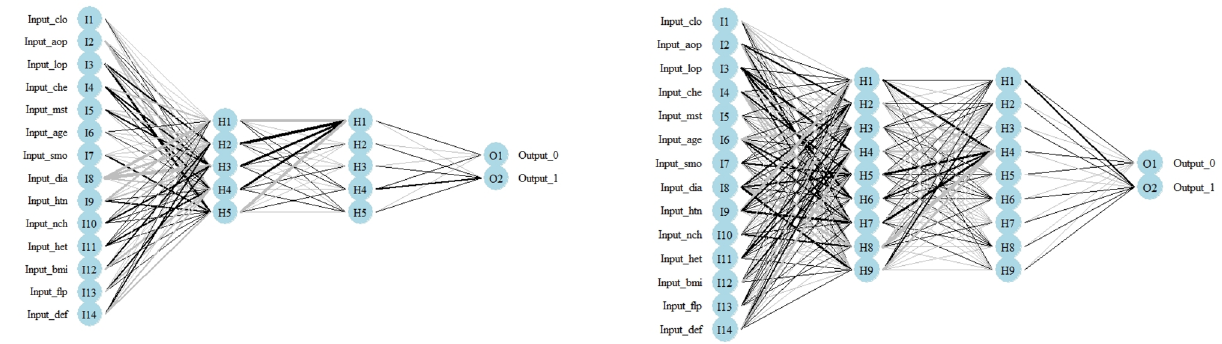
Figure 6. Plot diagram of RSNNS function, with five hidden neurons (left) and nine hidden neurons (right). Different options were tested with RSNNS package, however failed to give satisfying prediction values. R program version 3.6.3 (The R Foundation for Statistical Computing, Vienna, Austria) was used in creating